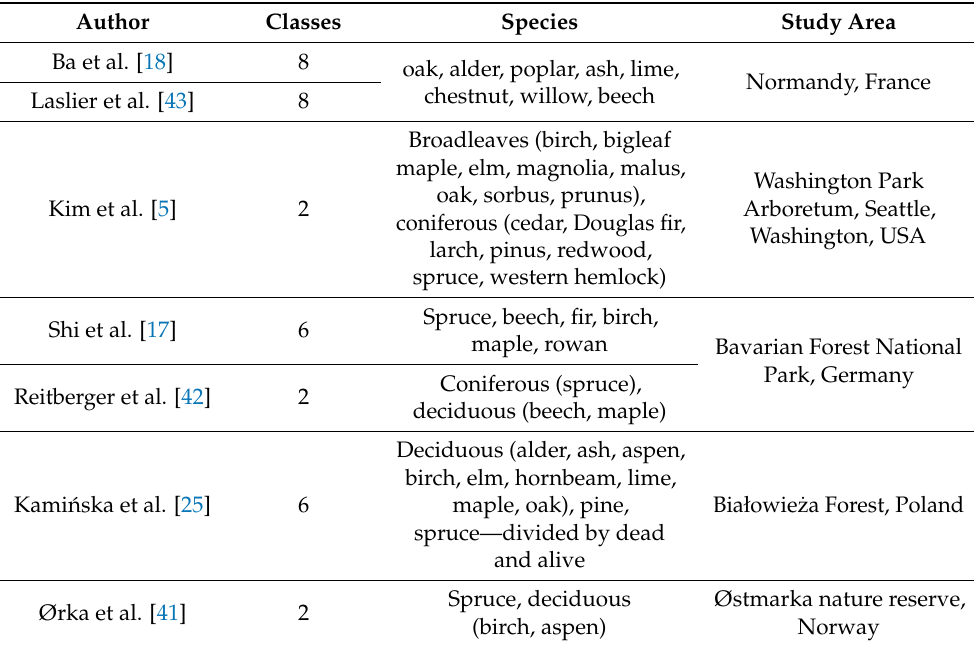
Table 1. Studies comparing ALS data from leaf-off and leaf-on